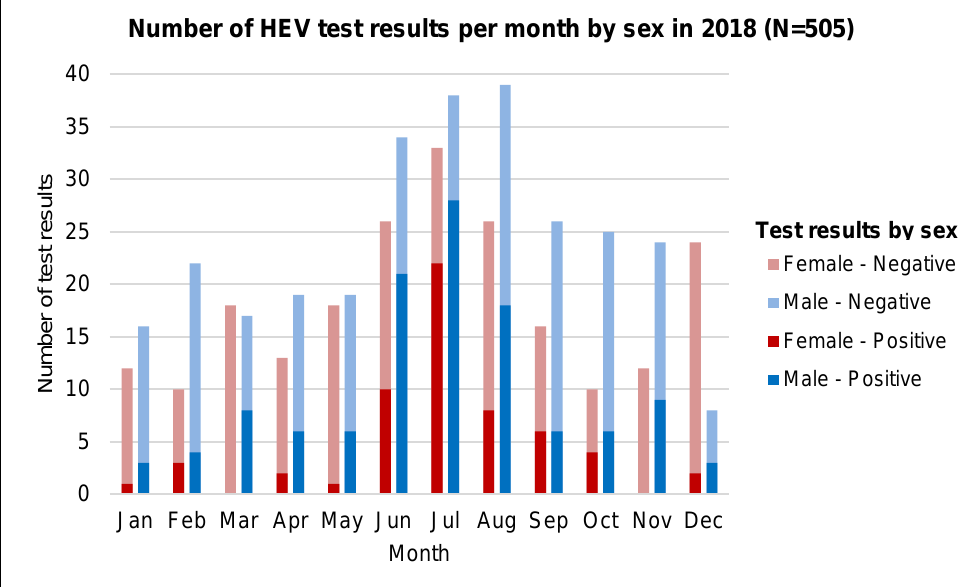
Figure 2. Number of HEV test results per month by sex in 2018. There are three major seasons in Bangladesh — summer (March to June), rainy season (July to October), and winter (November to February).